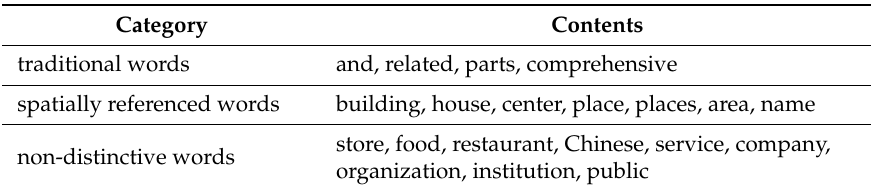
Table 1. Stop words in our